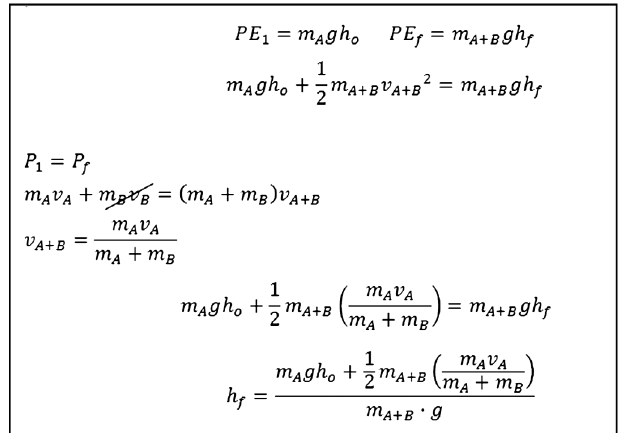
FIG. 3. Another example of a student’s solution in which the student mixed up several processes into one and applied the CME principle to an incorrect situation. Similar mistakes were classified in the ‘‘CME_2: Summing up KE and PE from differ- ent positions’’ category in Table